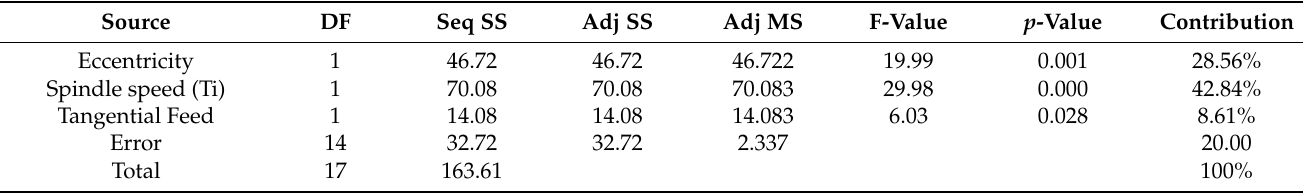
Table 4. Analysis of variance of the diametric error of Ti6Al4V.